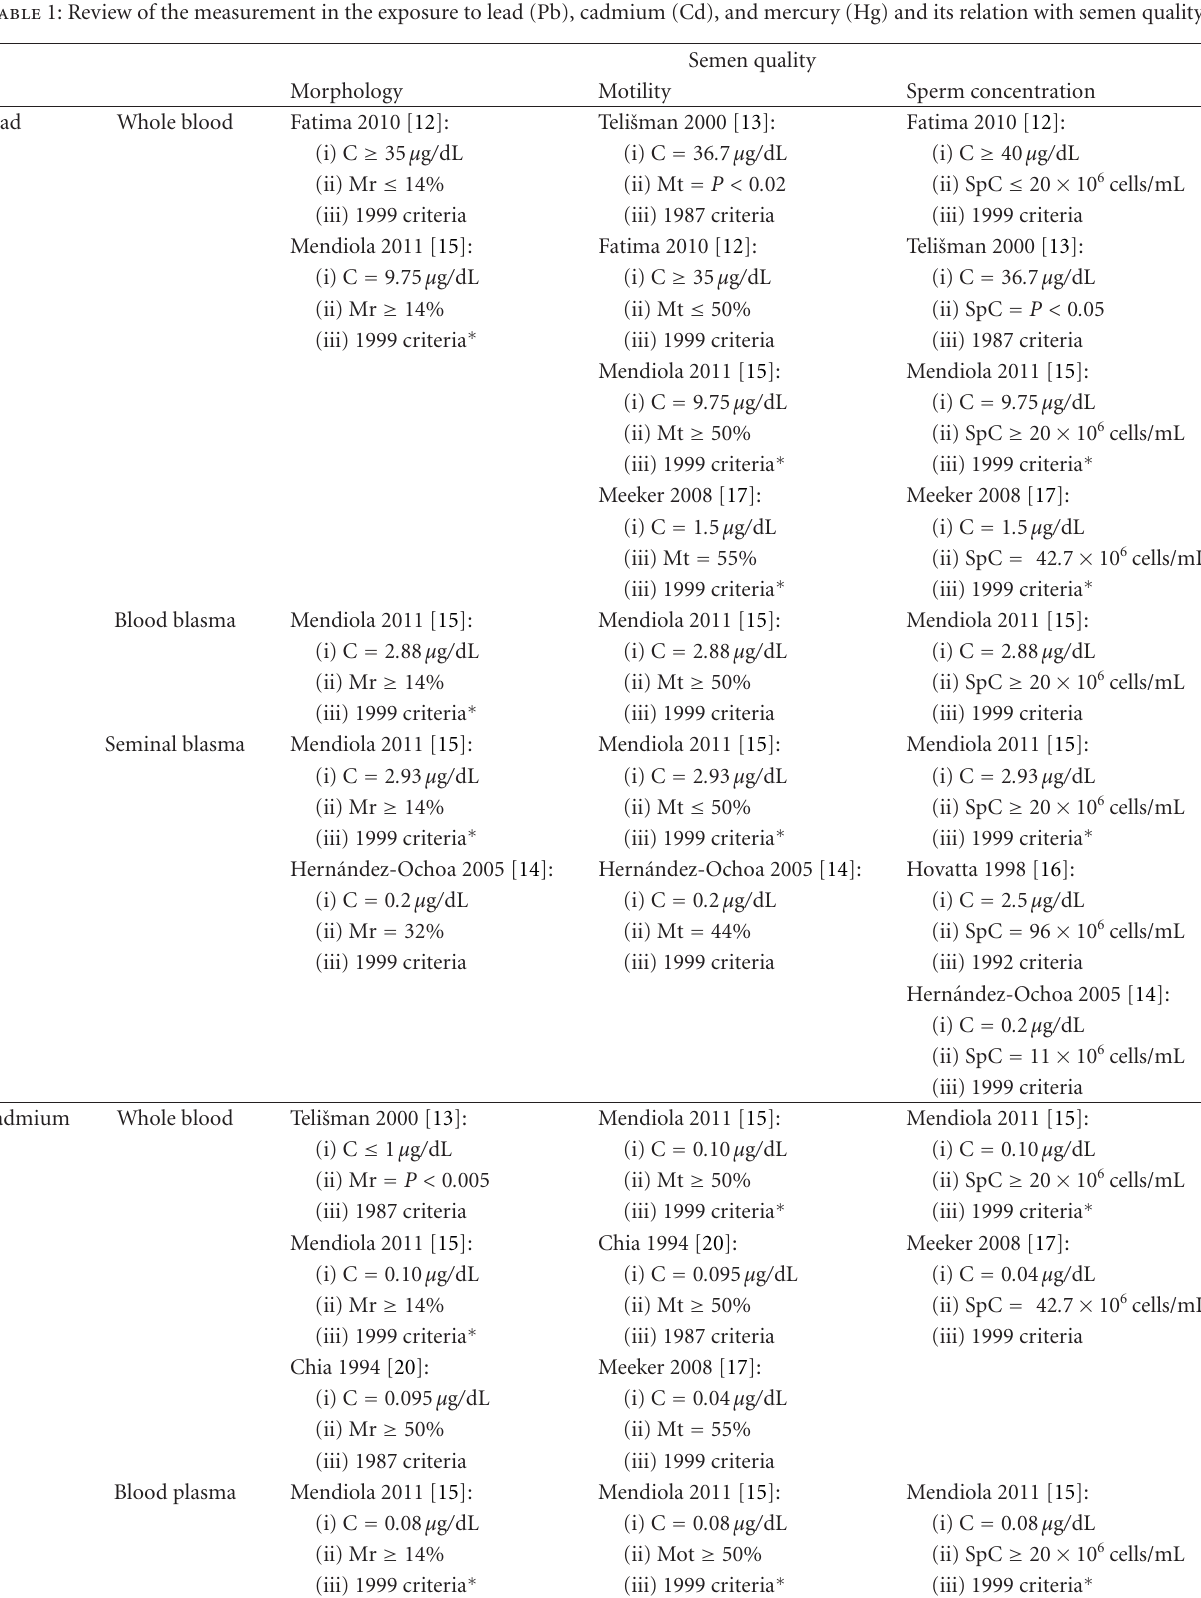
Table 1: Review of the measurement in the exposure to lead (Pb), cadmium (Cd), and mercury (Hg) and its relation with semen